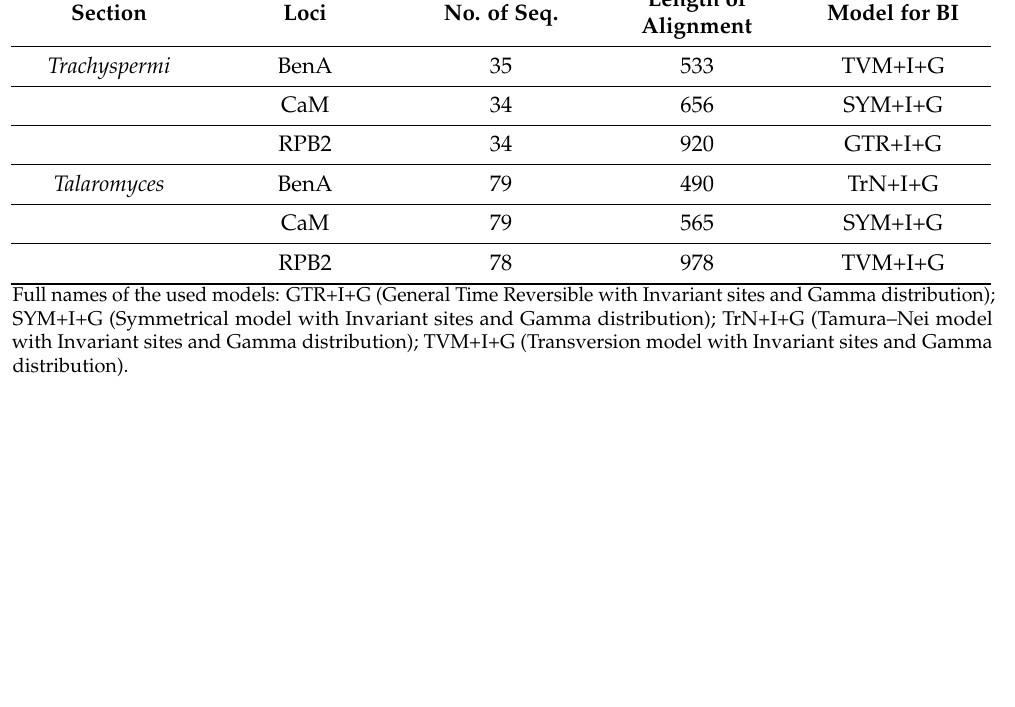
Table 4. Detailed characteristics of the datasets. Loci No. of Seq.